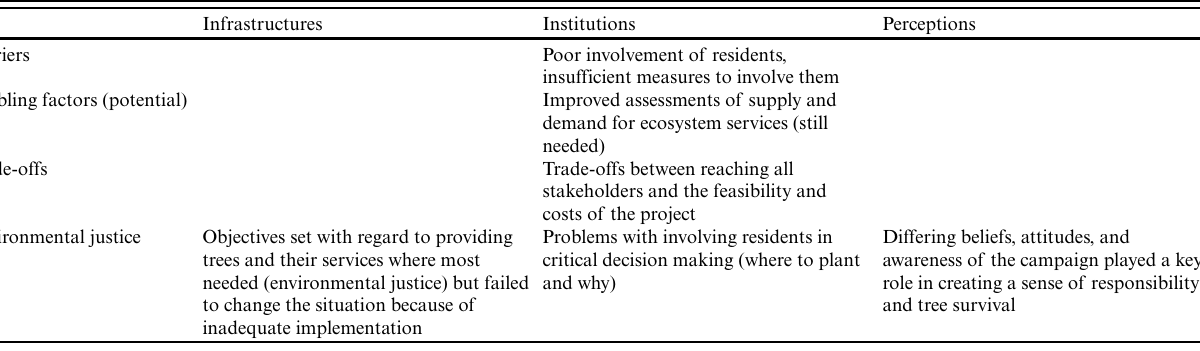
Table 7. ENABLE filters mediating the flow of benefits from GBI to potential beneficiaries translated into an analytical framework for the assessment of GBI-related initiatives—in the case of street tree planting and reforestation in New York